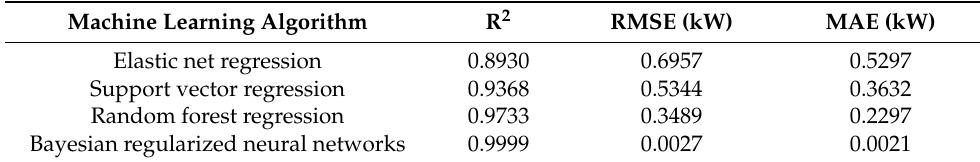
Table 8. Performance metrics—testing phase (20%).